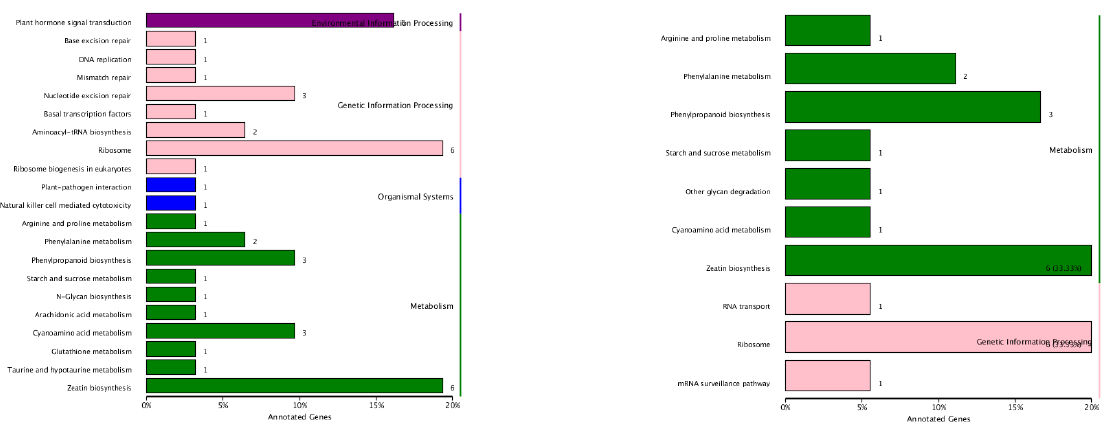
Figure 7. KEGG classification of differentially expressed targets of miRNAs. The labels on the y -axis provide the names of the metabolic pathways, and the digits on the x -axis are the numbers of genes Figure 7 KEGG Classification of differentially expressed targets of miRNAs. The ordinate - axis Y is the name of annotated for this pathway and the proportion of the total number of annotated metabolic pathway, and the horizontal coordinate - axis X is the number of genes annotated to this pathway and its proportion in the total number of annotated genes.